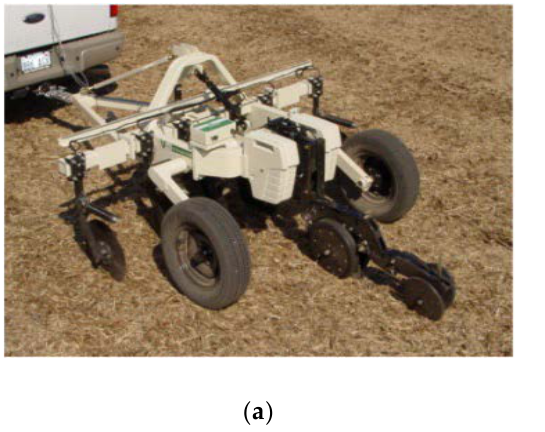
Figure 2. ERT prospection for precision farming. ( a ) Example of ERT on-the-go sensor [57]. ( b ) Example of ERT result showing the shallow conductivity map for an agricultural field (black to white colour scale, low to high values).